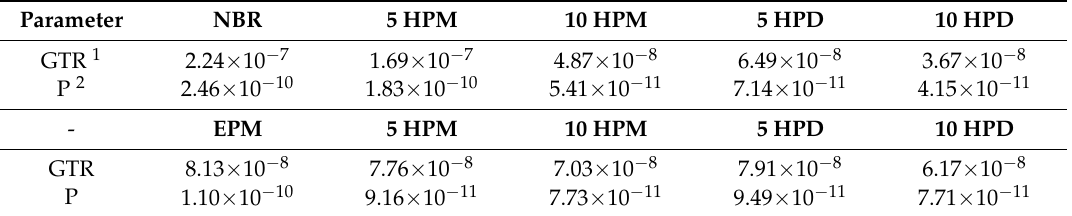
Table 5. Barrier properties of NBR and EPM composites filled with hybrid